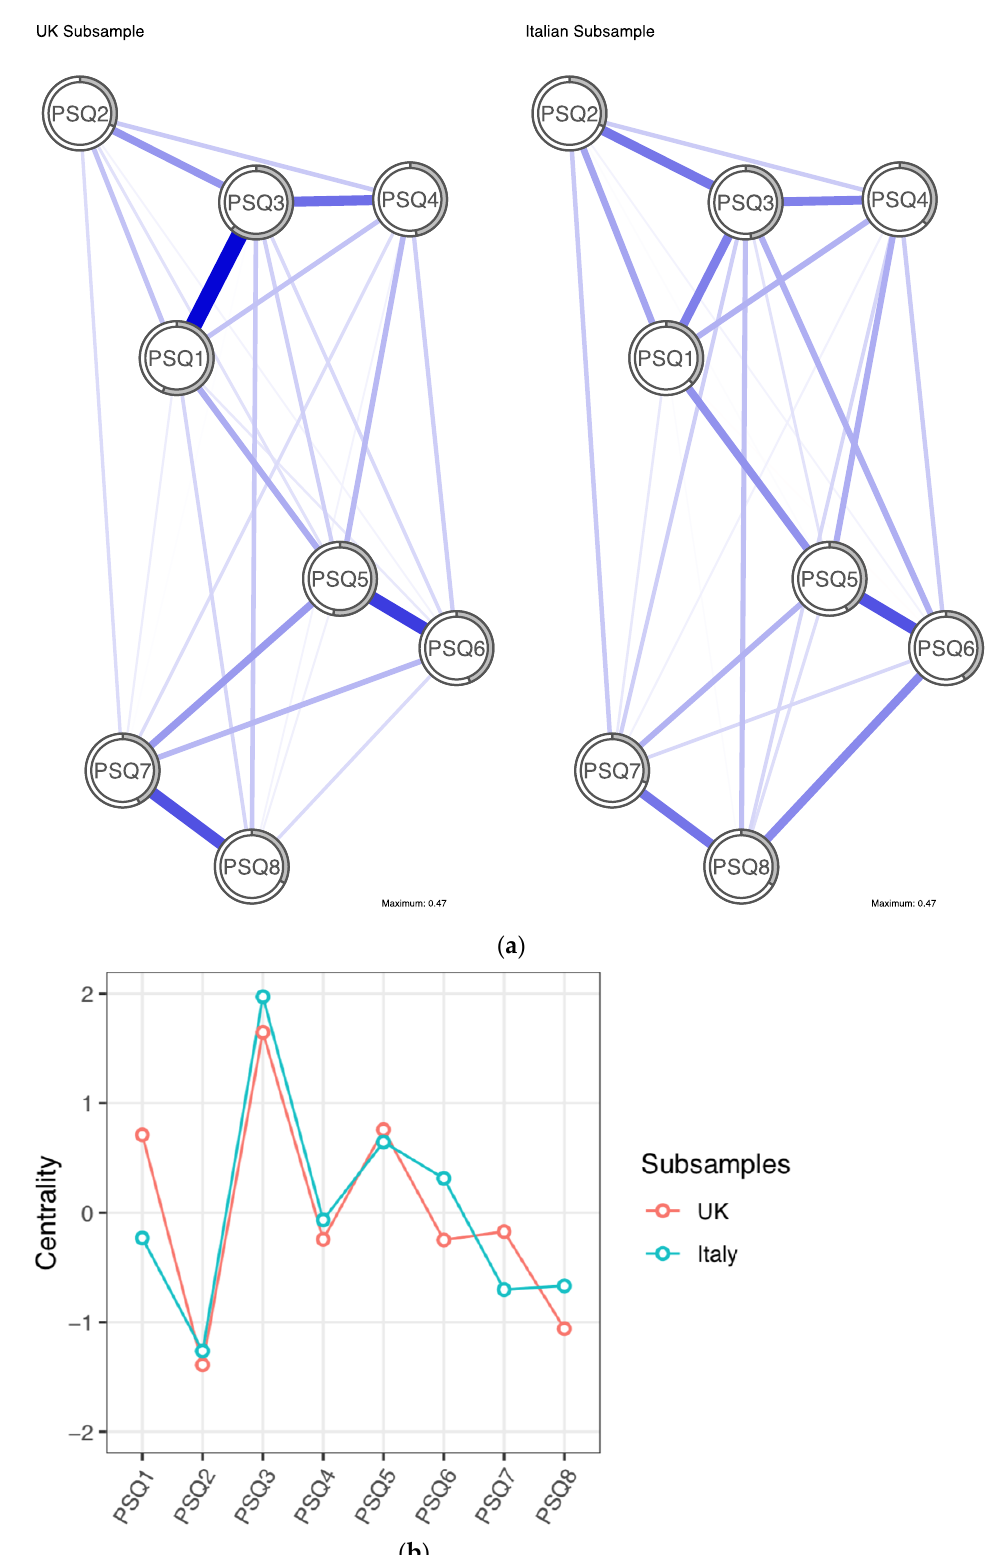
Figure 2. ( a ) Jointly estimated networks of identity disturbance in UK and Italian subsamples. Positive edges are represented by blue lines and shaded areas surrounding nodes represent node predictability. ( b ) Plot of node strength centrality comparison between country subsamples. Centrality rank order of five out of the six other PSQ items differed between the UK and Italian samples. In particular, PSQ1 ( changing sense of self ) was less central in the Italian network (ranked 5th) than in the UK network (ranked 3rd), whereas PSQ6 ( understanding mood change ) was more central in the Italian network (ranked 3rd) than in the UK network (ranked 6th). The UK subsample had the highest mean predictability of all subsamples at 0.46 (i.e., average amount of variance of a node is explained by its neighbours in the net- work was 46%). Predictability in the Italian subsample was 0.37. PSQ3 had the highest predictability in both networks, however rank order of node predictability differed be- tween subsamples for all other nodes. The NCT showed that the edge weights in the UK and Italian subsamples were significantly different ( p < 0.05). Post hoc tests identified that 3 of 36 pairs of edges (8%) significantly differed and these were PSQ1-PSQ3, PSQ6-PSQ8 and PSQ7-PSQ8. Global strength estimates did not significantly differ between the UK and Italy (UK = 3.37, Italy = 3.24, p = 0.15). Further comparison, adjusted for equal sample size, produced consistent results. The supplementary online results depict the remaining subsample comparisons. In terms of the networks for adults and adolescents, there were differences in centrality order between subsamples. In the adult subsample, PSQ3 ( unstable sense of self ; 2.02) was most central, whereas PSQ5 ( changing moods ; 1.38) was most central in the adolescent subsam- ple. The adolescent subsample had the lowest predictability (0.28) of all of the subsamples. Predictability in the adult subsample was 0.37. The NCT showed that there was no statis- tically significant difference between the adult and adolescent networks ( p = 0.33). The clinical and community networks were highly similar. PSQ3 ( unstable sense of self ) was the most central node for both clinical and community participants (1.52; 1.88 respectively), whilst PSQ2 ( others’ views ) was the least central in clinical and community subsamples ( − 1.26; −1 .19). Predictability was similar between subsamples at 0.40 in the clinical sub- sample and 0.32 in the community subsample. The NCT showed that the community and clinical subsamples were not significantly different from each other ( p = 0.80). Further analysis, adjusted for sample size, produced results consistent with the uneven sample size comparison. The networks for complex and other diagnoses were very similar, with strong edges being observed in both networks between PSQ1 ( changing sense of self ) and PSQ3 ( others’ views ) as well as PSQ5 ( changing moods ) and PSQ6 ( understandable mood